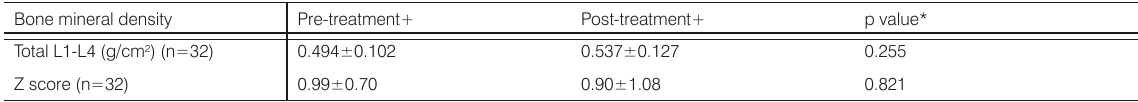
+ Data were shown as mean ± standard deviation. * Statistical analysis was performed by related samples t-test. The level of statistical significance was set at p<0.05. Table 3. Comparison of pre-treatment and 6 months post-treatment BMD